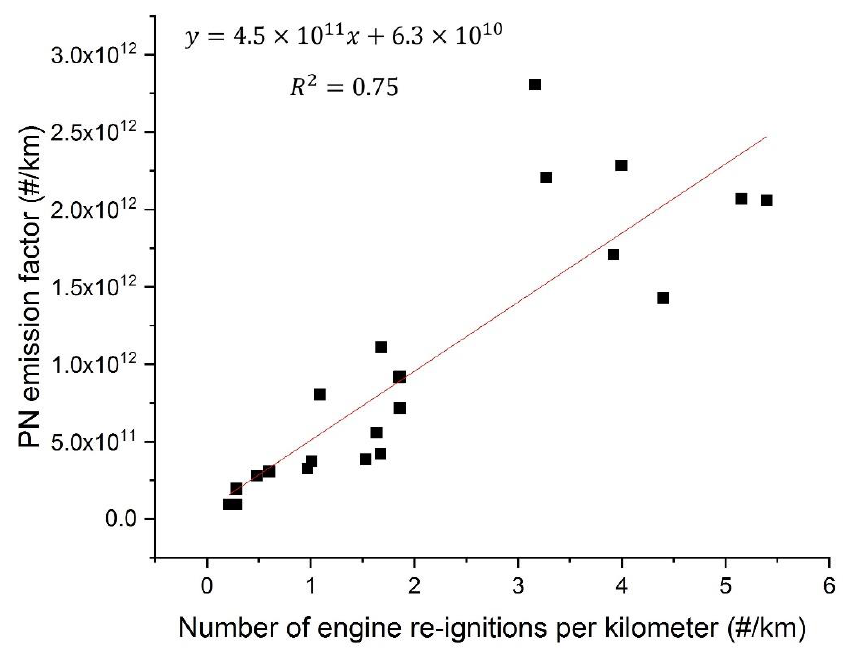
Figure 7. Modal (i.e., transient) and cumulative PN emissions over ( a ) the WLTC and ( b ) the shortened RDE-style cycle. Transient values are multiplied by 10 for scale. Vehicle speed is indicated on the secondary axis, with engine RPM indicated qualitatively in grey.